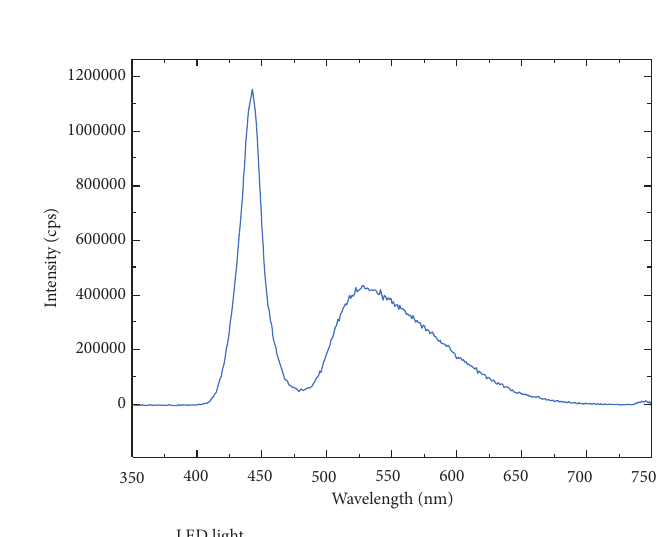
Figure 1: LED light (GM10743).